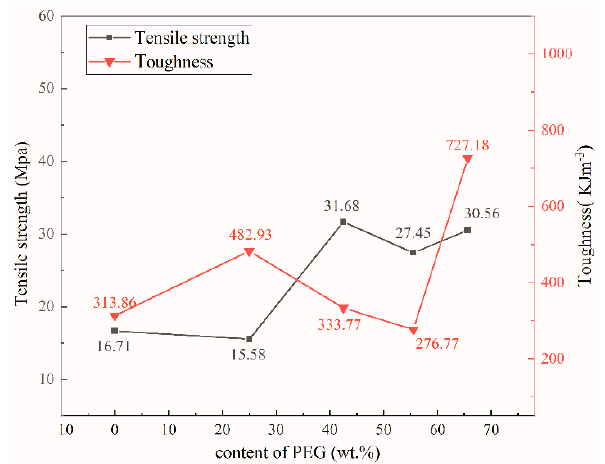
Figure 8. Tensile strength and toughness of composite films with different PEG contents. Table 3. Maximum tensile strength of nanocellulose-based composite films. Composite Film